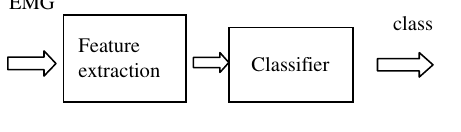
Fig. 5. Feature extraction and pattern